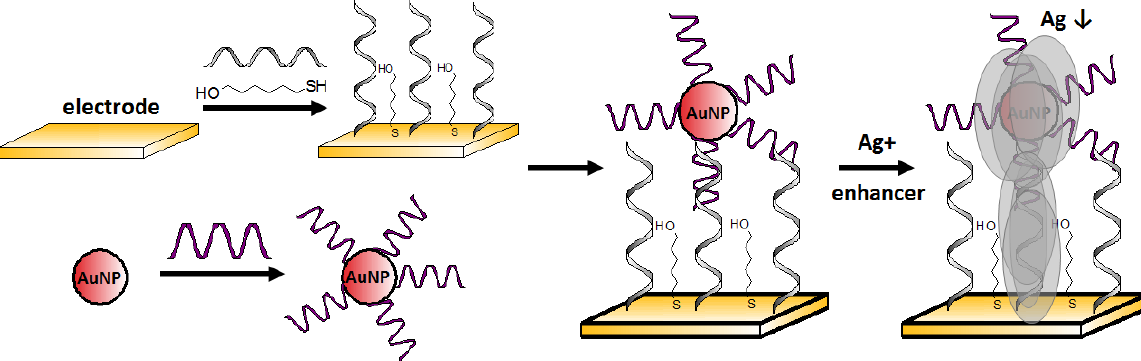
Figure 13. Electrochemical biosensor fabrication procedure and silver ion detection in the sandwich mode.